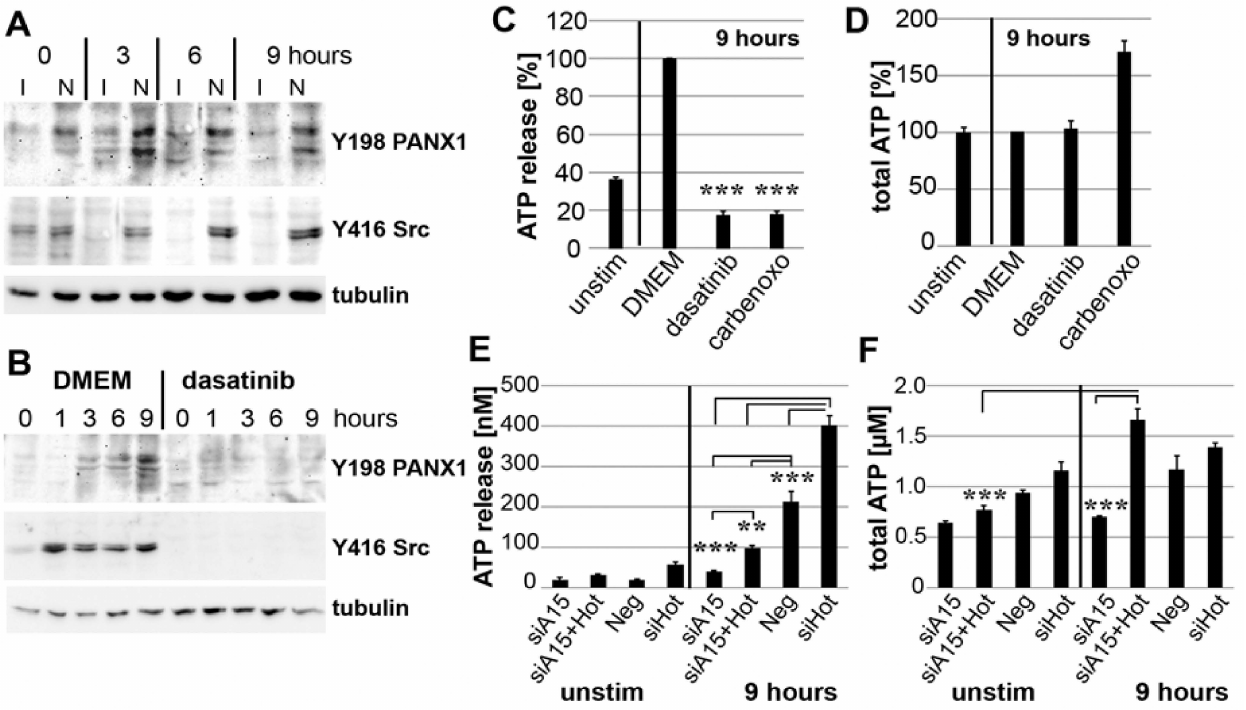
Figure 7. Strain-induced ATP release is dependent on activated pannexin-1 (PANX1). ( A ) Immunoblots from SF, strained for 0–9 h, with prior downregulation of ADAM15 by siRNA (I) or non-silencing siRNA (N), showing increased phosphorylations of PANX1 and Src in ADAM15-expressing SF. ( B ) Immunoblots of strained SF in the presence of dasatinib. ( C ) ATP release and ( D ) total ATP of strained SF in the presence of dasatinib (1 µ M) and the PANX1 channel inhibitor carbenoxolone (carbenoxo, 100 µ M). Data show the mean ± SD from one representative experiment out of at least 3 independent experiments. *** p < 0.0005, by Student’s t -test, for comparison of DMEM with inhibitor-treated SF. ( E ) ATP release and ( F ) total ATP from SF with downregulated ADAM15 (siA15), double knockdown of ADAM15/HOTAIR (siA15+Hot), single knockdown of HOTAIR (siHot), and negative siRNA (Neg). ** p < 0.005; *** p < 0.0005, using Student’s t